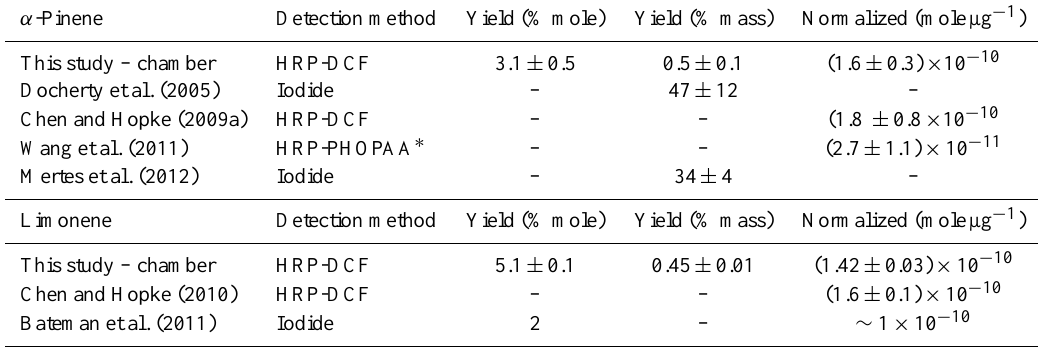
Table 1. Peroxide yields from fresh SOA samples (this study) and from literature reports (see text for explanation). α